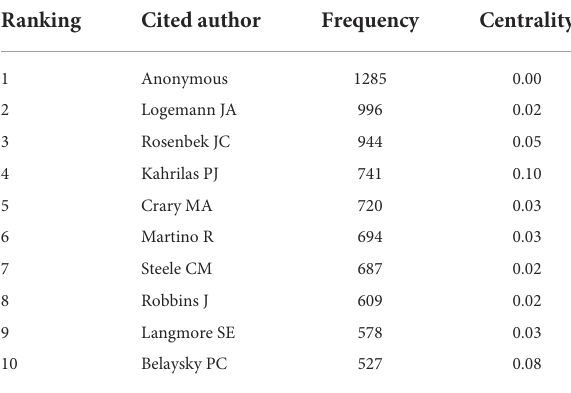
TABLE 4 The top ten cited authors and centrality in the research field of dysphagia from 2012 to 2022. Ranking